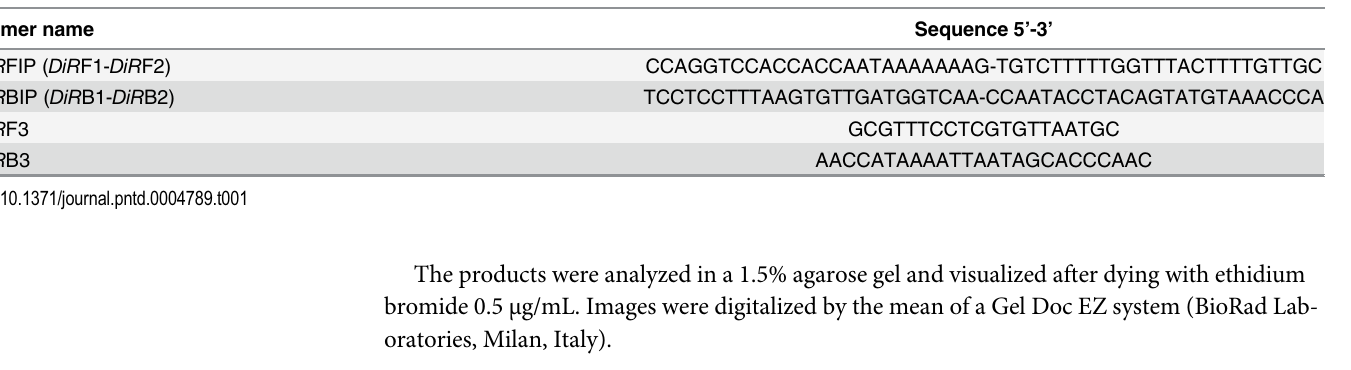
Table 1. List of primers for D . repens specific